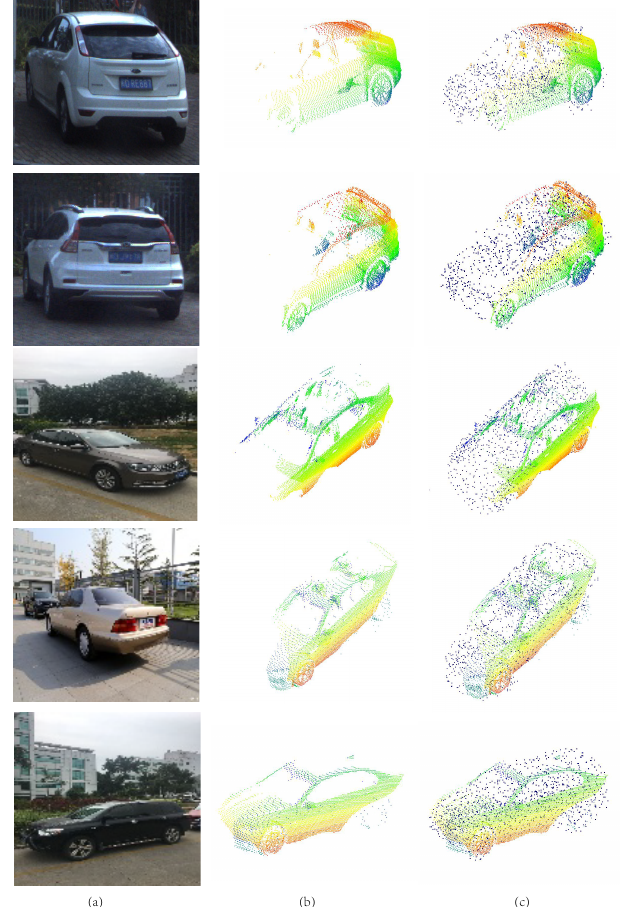
Figure 13. More results of MLS data. ( a ) Street images. ( b ) Original MLS point clouds. ( c ) The completion results of PCCNet